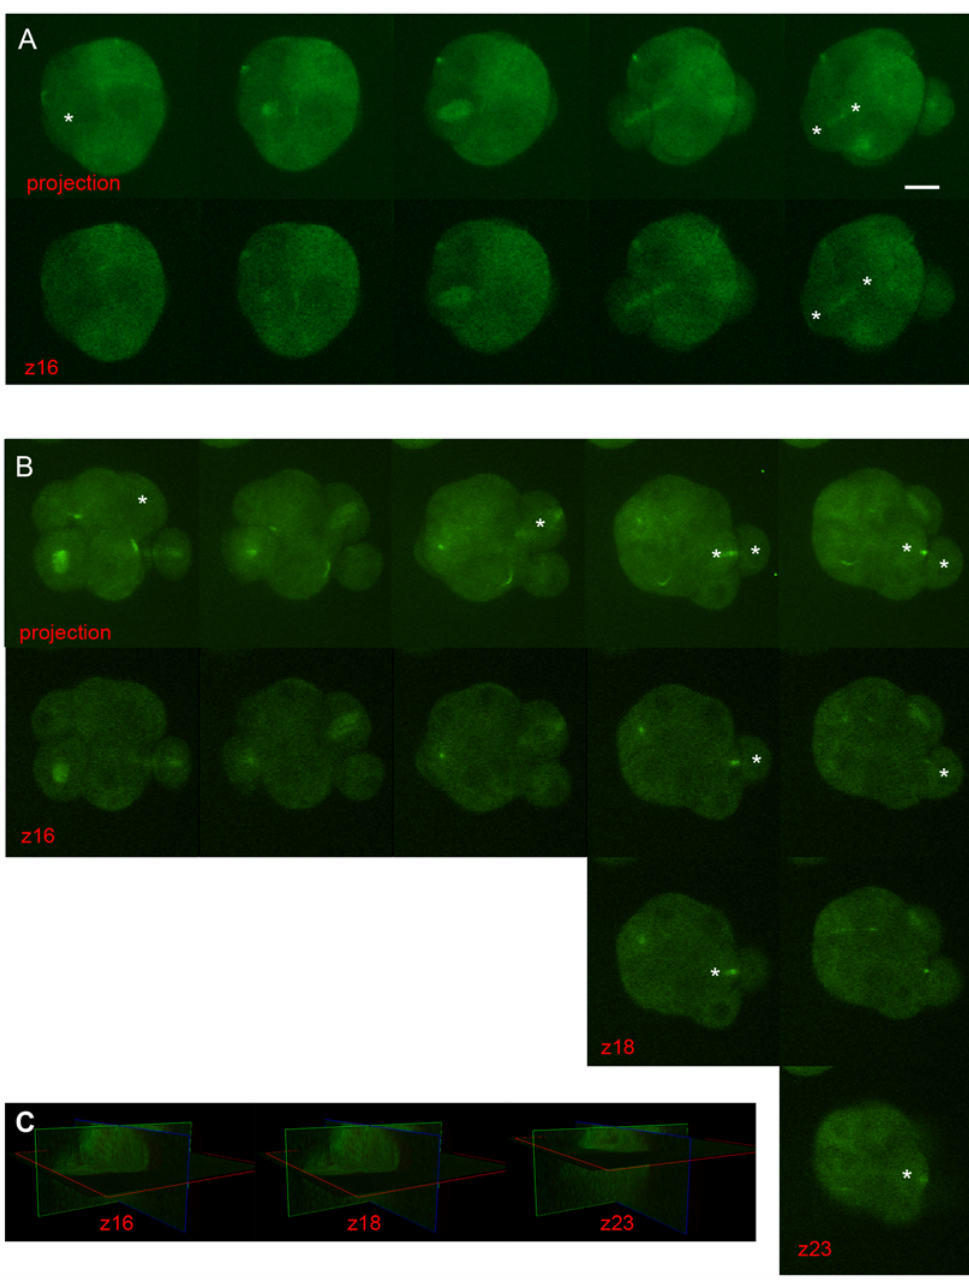
Figure 6. Relocation of blastomeres at the periphery after an asymmetric division in aPKC l depleted embryos. (A): Spinning disk microscope analysis of a siRNA-Crtl injected embryo expressing exogenous tubulin-GFP during the 8- to 16-cell stage mitosis (time between images: 20 min). Upper panel: projection of 30 Z planes (Z step, 2 mm). Bottom panel: only the 16th z plane is shown (corresponding to the center of the embryo. The asterisks show the mother cell and the two daughter cells after an asymmetric division. Note that the two daughter cells are in the same plane and that the inside cell is correctly localized. siRNA were microinjected at the 2-cell stage. Scale bar: 20 m m. (B): Spinning disk microscope analysis of a siRNA-aPKC l injected embryo expressing exogenous tubulin-GFP during the 8- to 16-cell stage mitosis. Upper panel: projection of 31 Z planes (Z step, 2 mm). Bottom panels: the 16th, 18th and 23rd z planes are shown. Note that the ‘‘inside’’ daughter cell moves toward the top and periphery of the embryo (from the 16th z planes to the 18th 20 min. later and finally to the 23rd z plane). siRNA were microinjected at the 2-cell stage. (C): 3D images showing the position of the three different z planes (in red). doi:10.1371/journal.pone.0007117.g006 groups of embryos at the 16- and 32-cell stages (Table 3), extent (Table 3). By contrast, at the 32-cell stage, the contribution indicating that expression of these aPKC l constructs had no effect of aPKC l defective blastomeres to inner cell mass was significantly on cell division rate. We did not notice any significant difference at higher compared to blastomeres derived from the non-injected the 16-cell stage, aPKC l -WT and aPKC l -K273E expressing blastomere (Table 3). Indeed, 10 out of 16 ( < 62%) aPKC l - blastomeres contributing to inner and outer cells to the same K273E expressing cells were found in the inner cell mass,